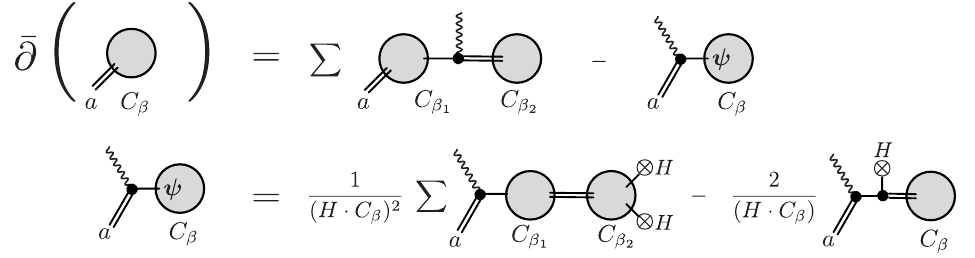
Figure 2 . Upper line: graphical representation of the holomorphic anomaly equation (2.49) for the generating function of relative Gromov-Witten invariants, F . As in figure 1, single lines denote a | C β (1 , 1) -form fields, double lines (2 , 2) -form fields, wavy lines the antichiral ( − 1 , − 1) -charged field, and solid bullets classical couplings. The second line shows the factorization of the gravitational descendant term, referring to appendix A.1. The crossed circles denote insertions of an auxiliary divisor H , as explained there. A noteworthy feature is that in the lower sum also the “trivial” factorization C = C + C , where C = C and C = point, contributes. In this case there is β β 1 β 2 β 1 β β 2 only a classical contribution from C , which means that the other component of this factorization β 2 can contribute to the linear term in the anomaly as well.